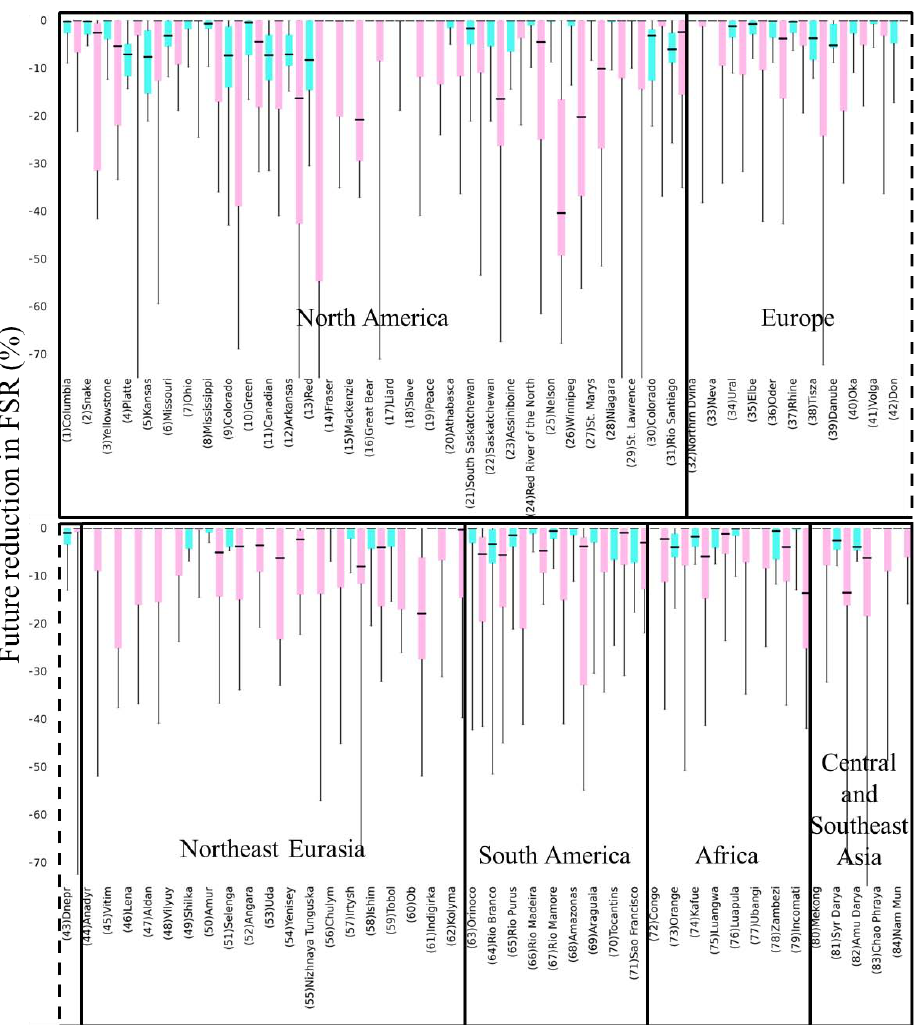
Fig. 3. Box plot of the median values of future reductions in FSR (%) by the FSR-MAD (blue box) and FSR-FLVAR methods (pink box) in the 84 individual river basins. The height of each box indicates the interquartile range (75th–25th percentiles) and the bold line within each box indicates the median value. The solid thin lines represent the maximum and minimum of the reduction in FSR for all of the atmosphere–ocean general circulation